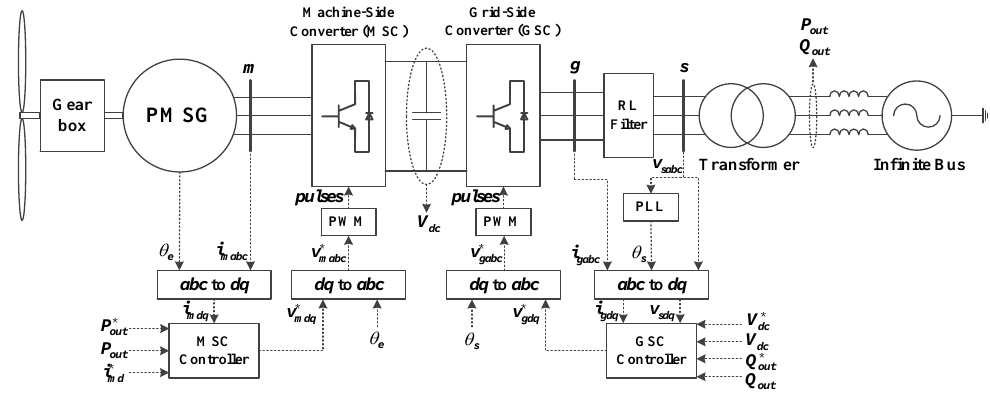
Figure 1. Schematic diagram of the